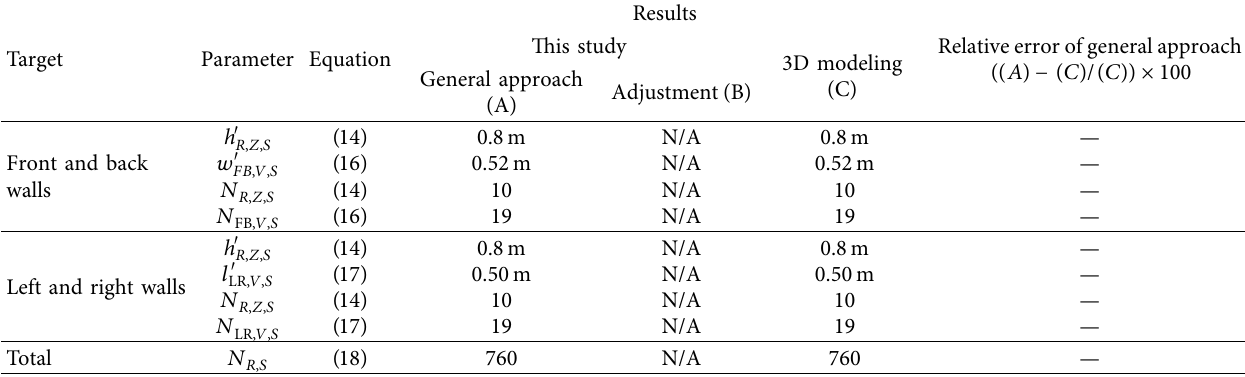
Table 2: Segmentation strategy derived for the specified rectangular prism-type object assumed in this study and comparison with the results from 3D modeling using Rhino [15].